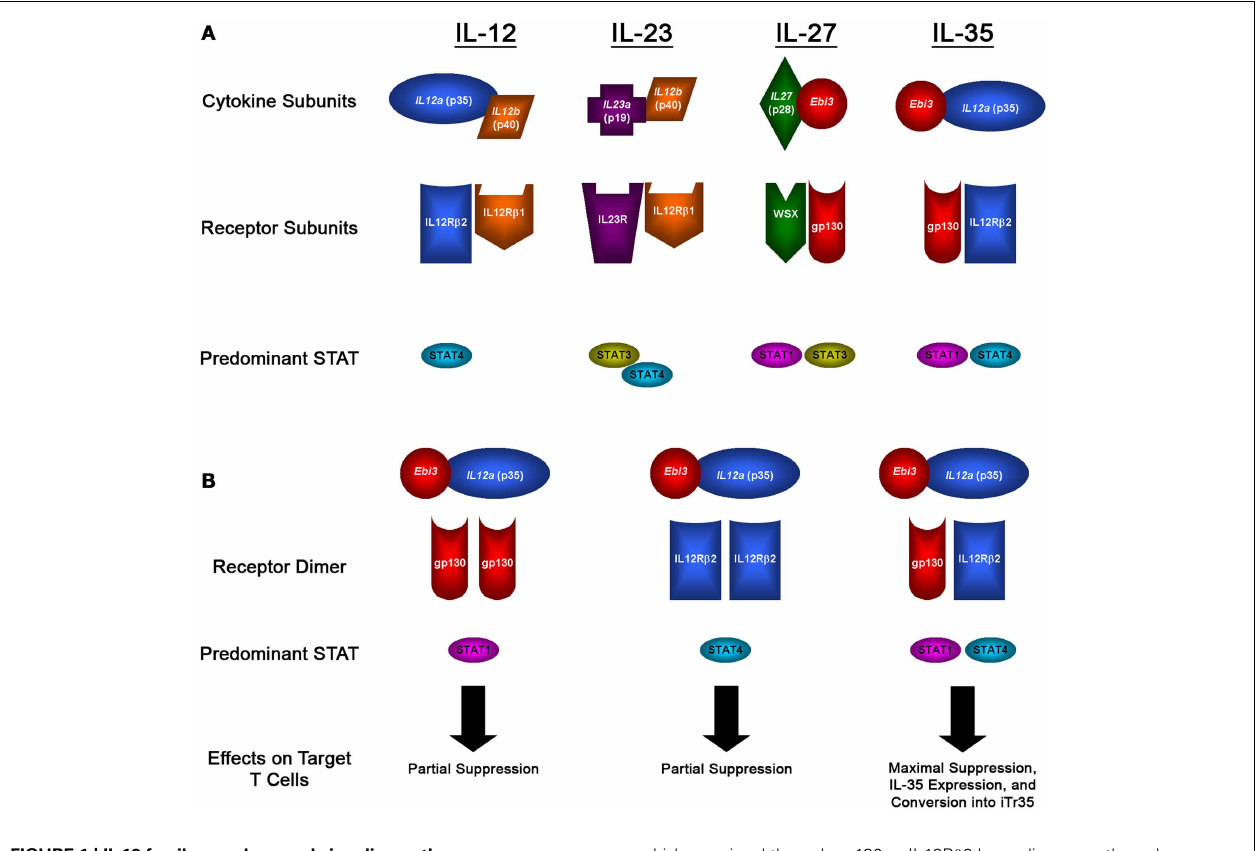
FIGURE 1 | IL-12 family members and signaling pathways . (A) Diagram showing the subunits that form the heterodimeric IL-12 family of cytokines, the subunits that form their receptors, and the predominant STAT molecules that transmit their signals. (B) Diagram showing the potential receptor and signaling pathways utilized by IL-35,